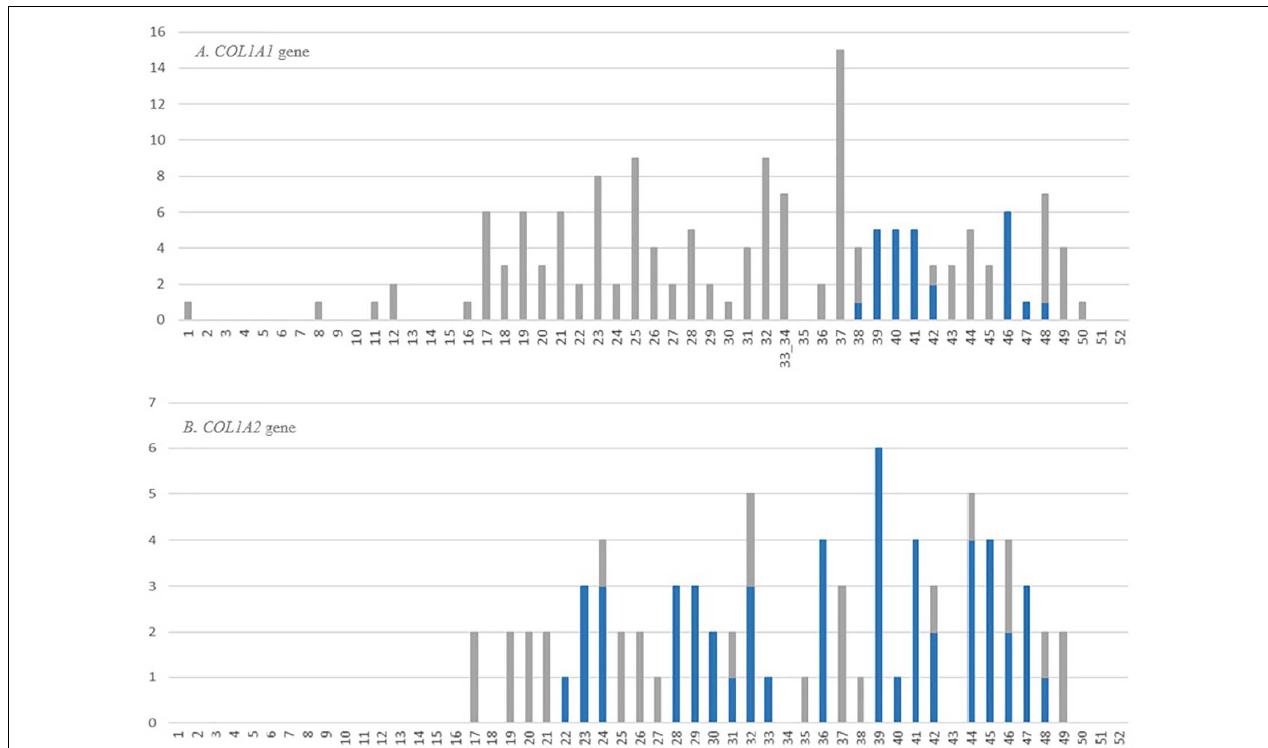
FIGURE 5 | Number and distribution of distinct lethal glycine substitutions along the alpha1 chain of the (A) COL1A1 and (B) COL1A2 genes. The vertical axis shows number of reported mutations, and the horizontal axis shows the gene exons. The bars refer to the number of distinct lethal variants reported in a particular exon. The gray bars represent mutations located outside the lethal regions, blue bars represent mutations corresponding to the location of lethal